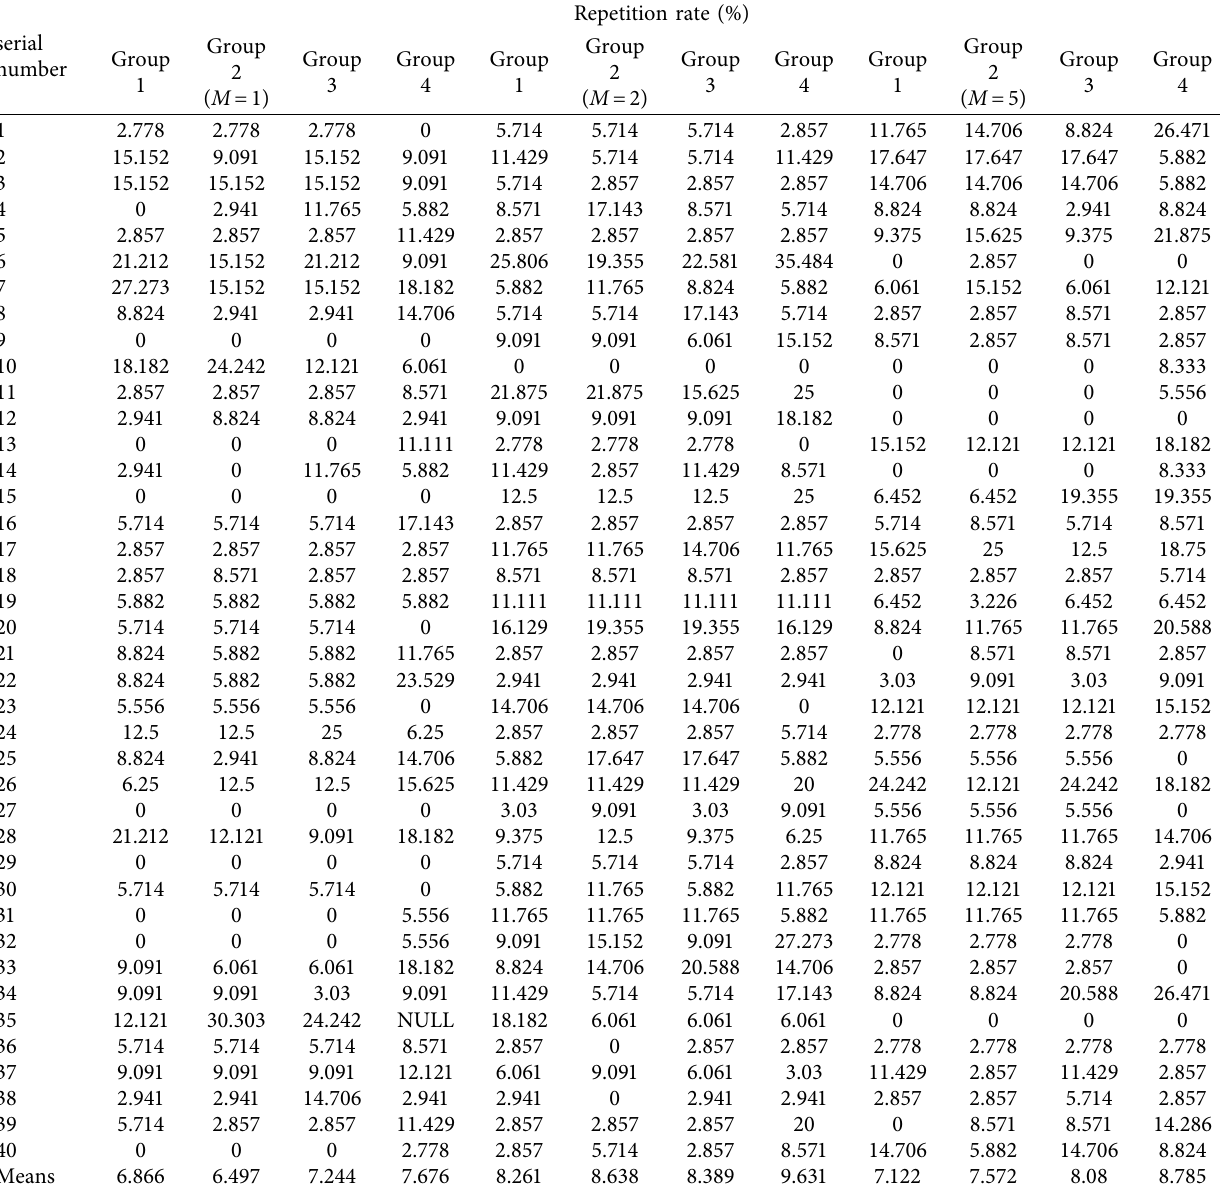
Table 4: The repetition rates in different conditions in 120